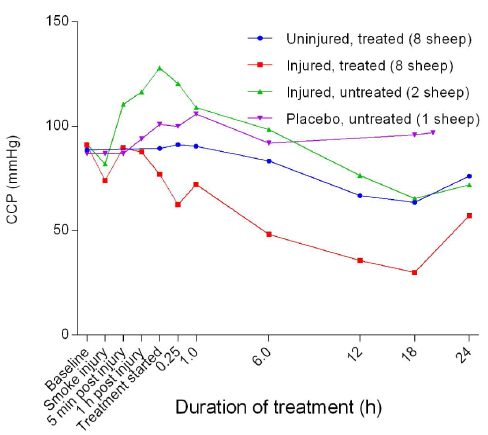
Figure 35. Coronary perfusion pressure (CPP) (Mean ± SD, error bars not shown) in smoke and non-smoke injured sheep that received extracorporeal life support alongside as compared to that in controls.